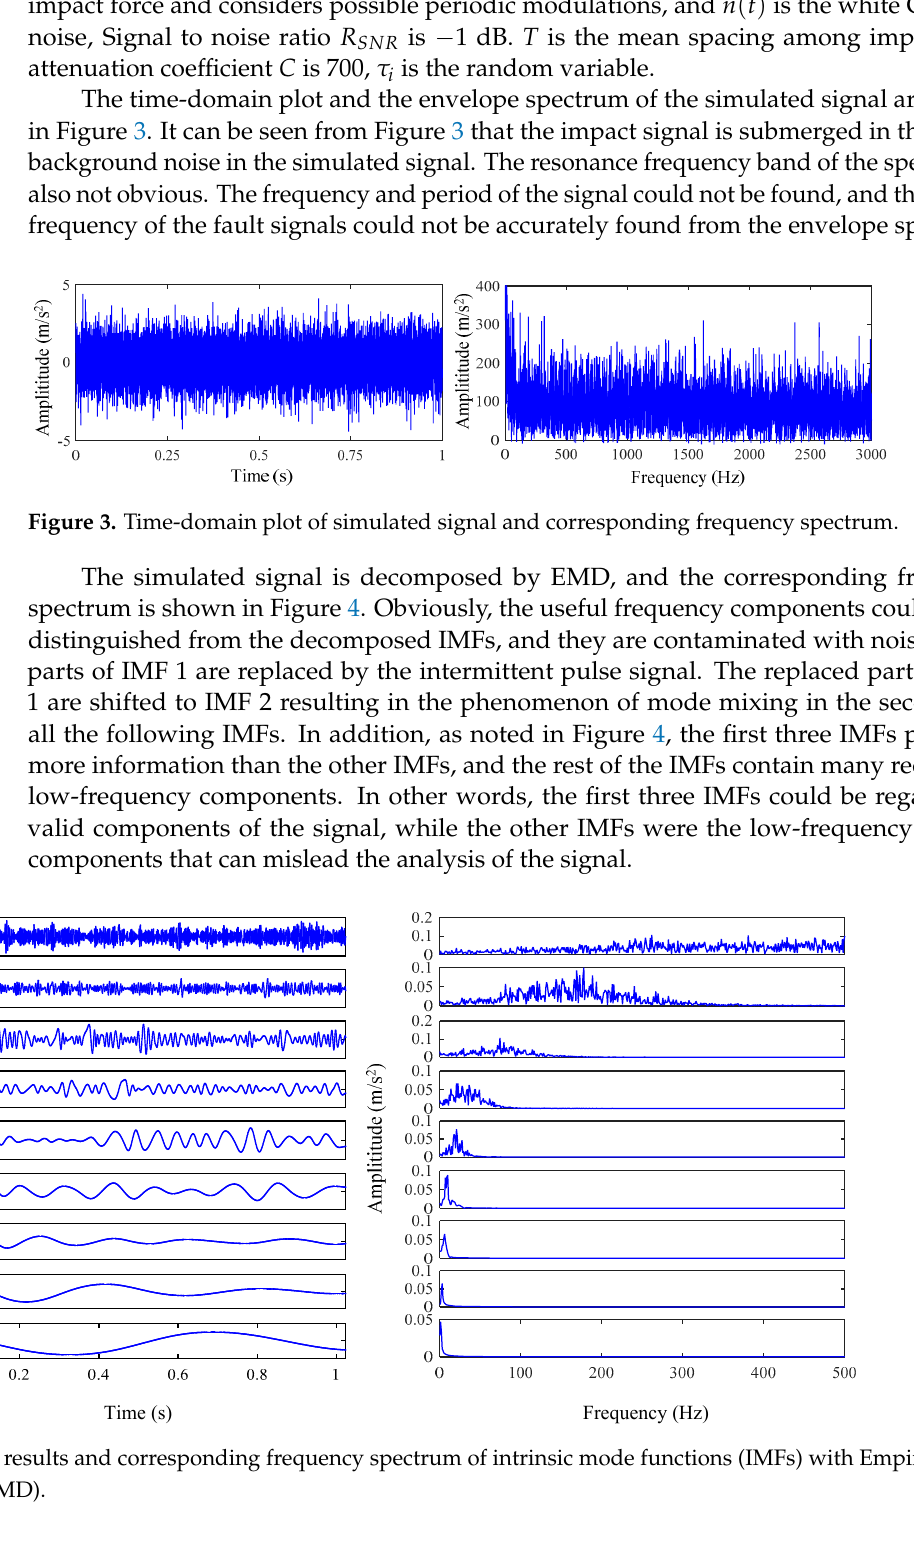
Figure 5. Decomposition results and corresponding frequency spectrum of IMFs with Ensemble EMD (EEMD).